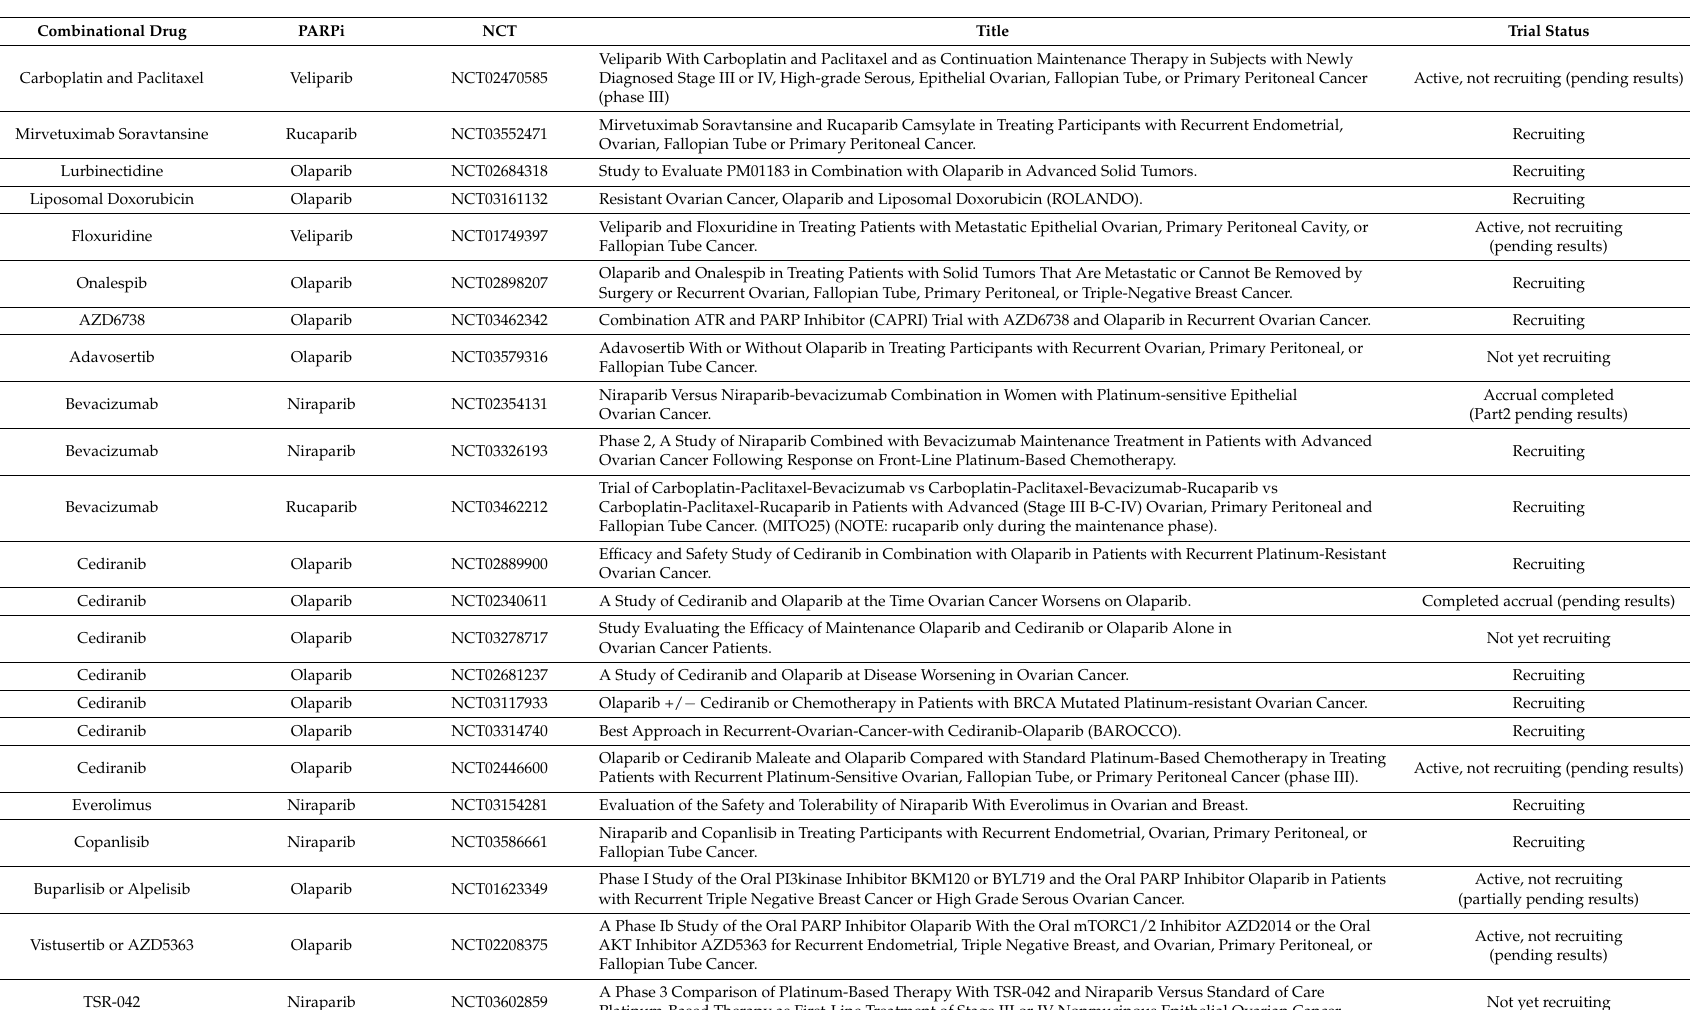
Table 2. Current recruiting trials combining PARPi with other drugs in Ovarian Cancer (and some examples of active trials not recruiting with pending results). Combinational